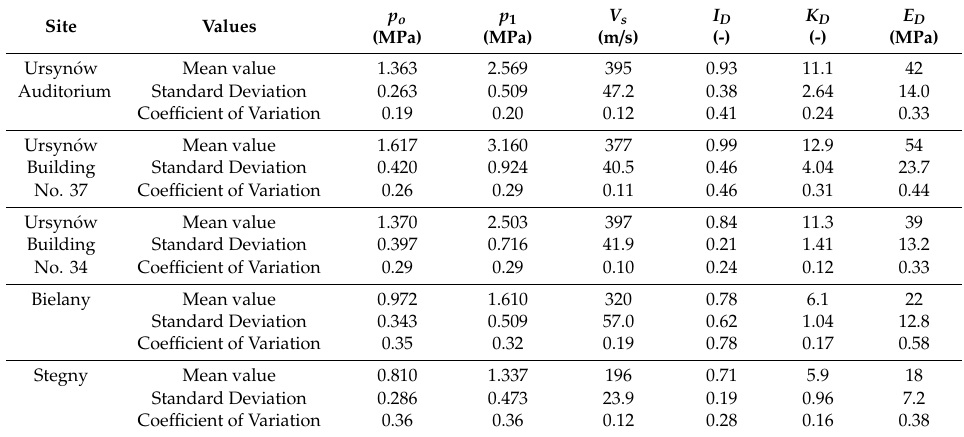
Table 3. Mean value, standard deviation, and coe ffi cient of variation of: The corrected first pressure reading p o or the corrected second pressure reading p 1 , shear wave velocity V s , material index I D , horizontal stress index K D , and dilatometer modulus E D .